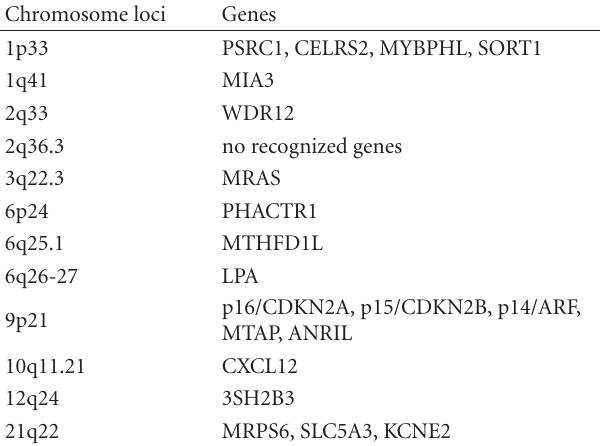
Table 4: Genes located within or adjacent to the loci associated with